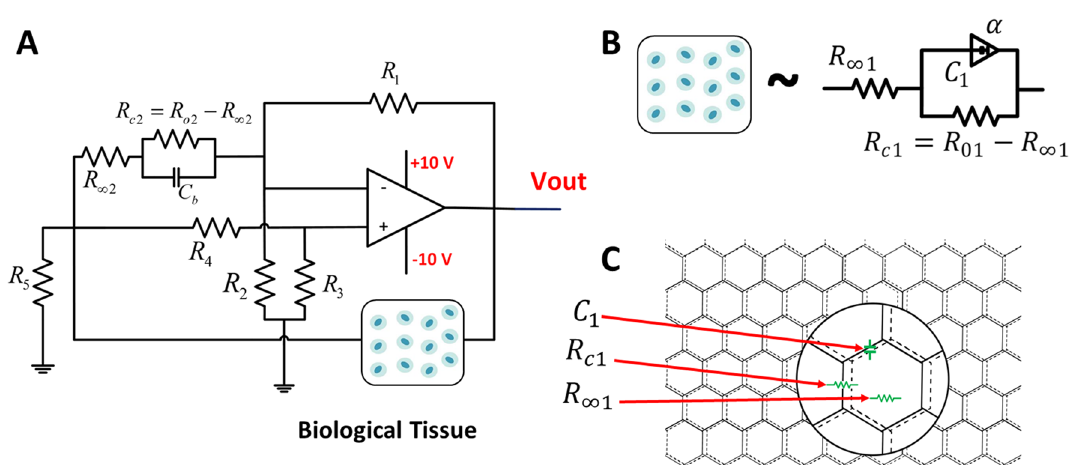
Figure 6. The modified SRCO circuit. ( A ) A parallel RC branch is replaced by the biological tissue. Many Models have been proposed to model the behavior of impedance introduced by various biological tissues. In ( B ) Single Dispersion Cole model which is equivalent to the biological tissue, and in ( C ) each parameter of the Cole model is related to the cell wall, and liquid gel of the actual Aloe Vera pulp